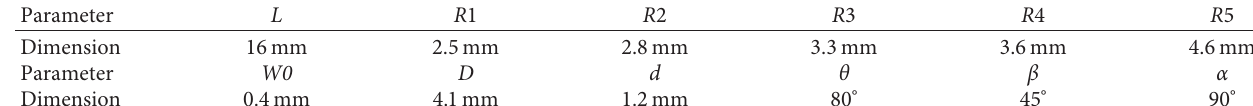
Table 1: Dimensions of antenna in Figure 3.